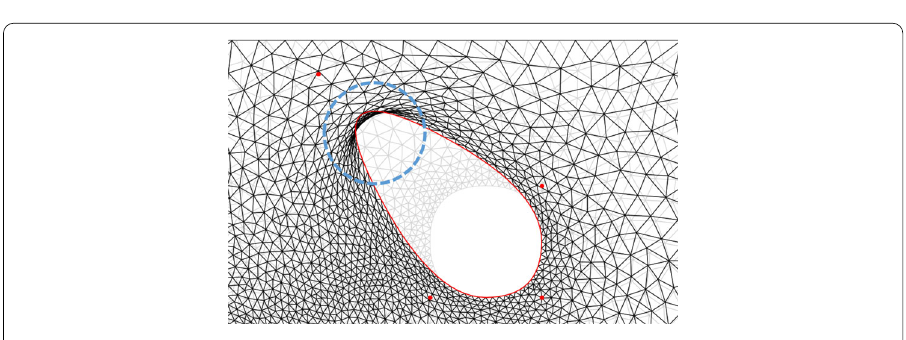
Fig. 12 Example of the orthotropic plate with two holes: evolution of the transformation Jacobian of each Gauss point as a function of the iteration number for the first optimization run ( (cid:5) Jac = 0 . 1)